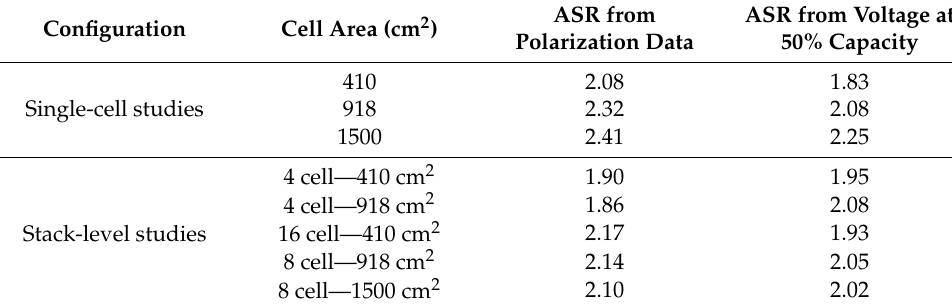
Table 5. Estimated area specific resistance (ASR) in m Ω .cm